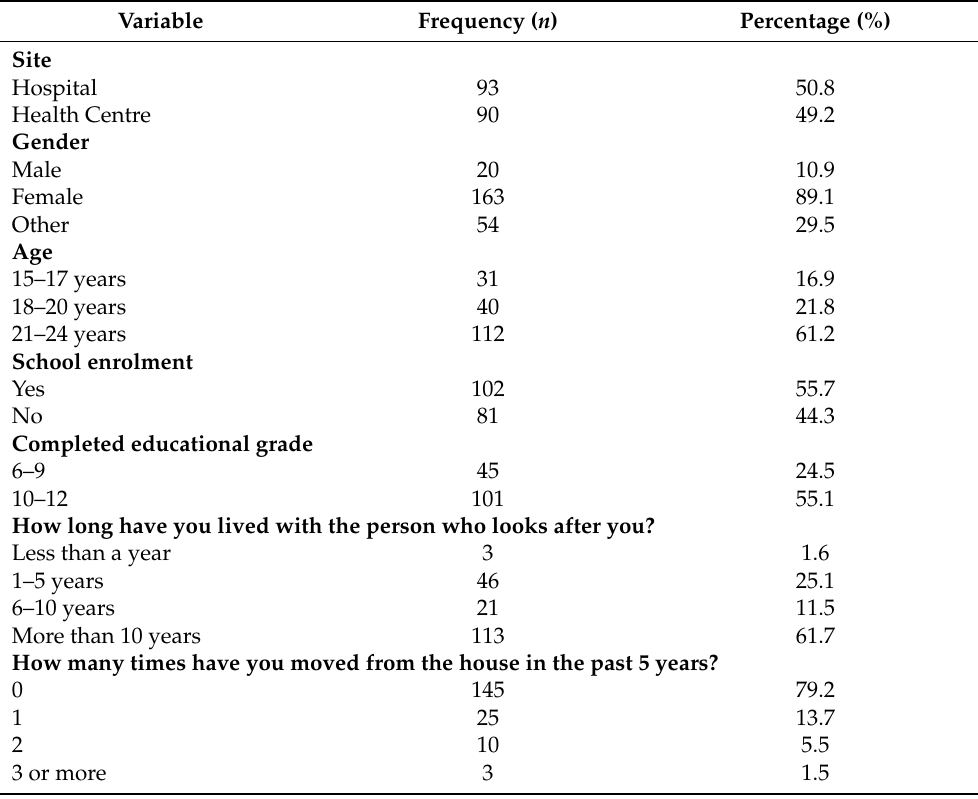
Table 1. Demographic characteristics of the